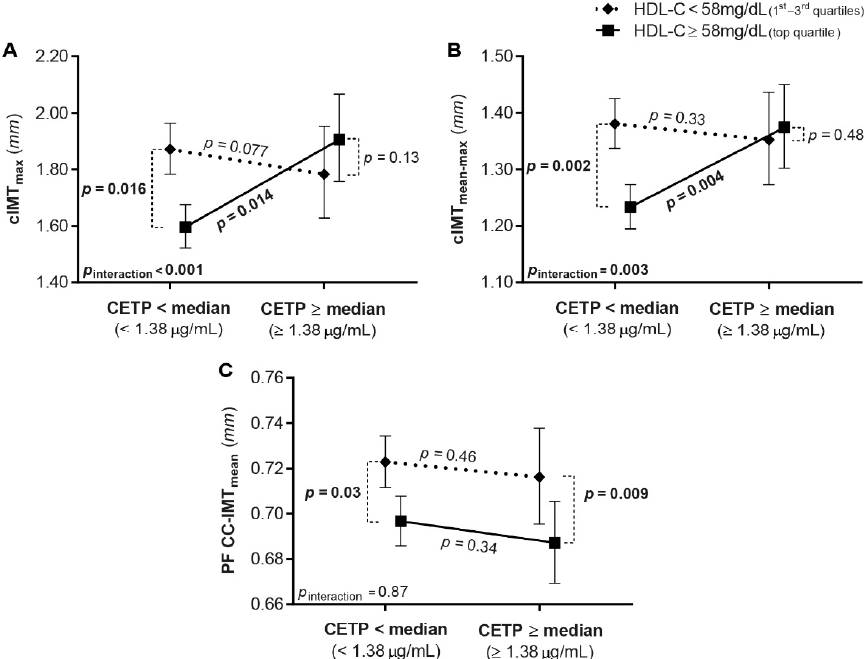
Figure 1. CETP × HDL-C interaction in predicting cIMT. Drug-free subjects ( n = 552) were stratified according to high-density lipoprotein cholesterol (HDL-C; upper vs. pooled quartiles 1–3) and cholesteryl ester transfer protein (CETP; above vs. below the median value) plasma concentrations. CETP was positively associated with ( A ) maximal carotid intima-media thickness (cIMT max ) and ( B ) the average of maximal cIMT measurements (cIMT mean–max ), in the top HDL-C quartile only. HDL-C was negatively correlated with cIMT max and cIMT mean–max when CETP concentration was below the median. There was a significant CETP × HDL-C interaction. ( C ) HDL-C was negatively correlated with the average plaque-free common carotid IMT (PF CC-IMT mean ) irrespective of CETP concentration (i.e., no interaction between CETP and HDL-C). The analyses were adjusted for age, sex, latitude, total cholesterol, and log-triglycerides. Table 2. Associations between single-nucleotide polymorphisms (SNPs) at CETP locus and cIMT max in the full IMPROVE cohort and in subjects stratified by HDL-C quartiles (pooled quartiles 1–3 vs. top quartile). Full Cohort HDL-C < 58 mg/dL HDL-C ≥ 58 mg/dL ( n = 3436) ( n = 2673) ( n = 763)